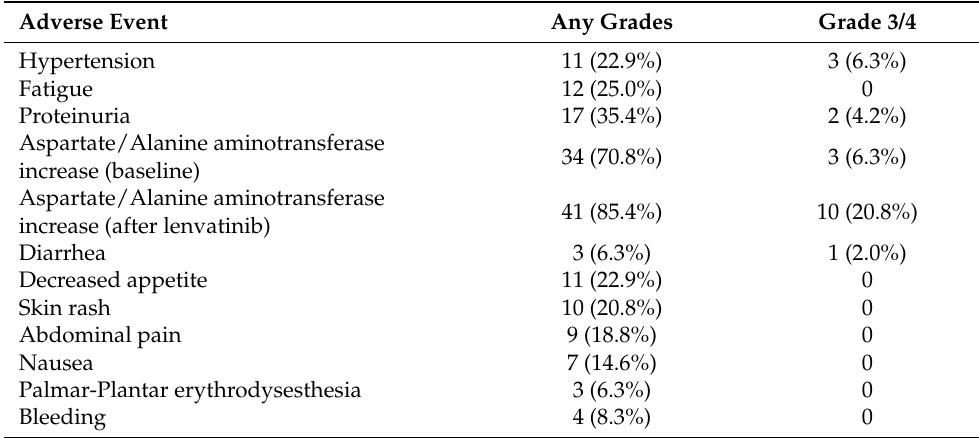
Table 4. The treatment-related adverse events in the 48 patients with unresectable hepatocellular carcinoma who received atezolizumab plus